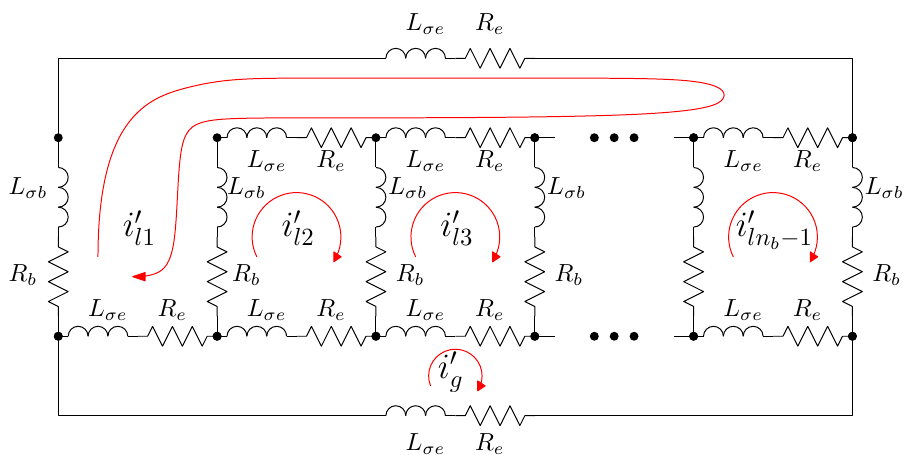
Figure 9. Rotor loops in a squirrel cage rotor of n b bars with a single broken end ring segment () f 1